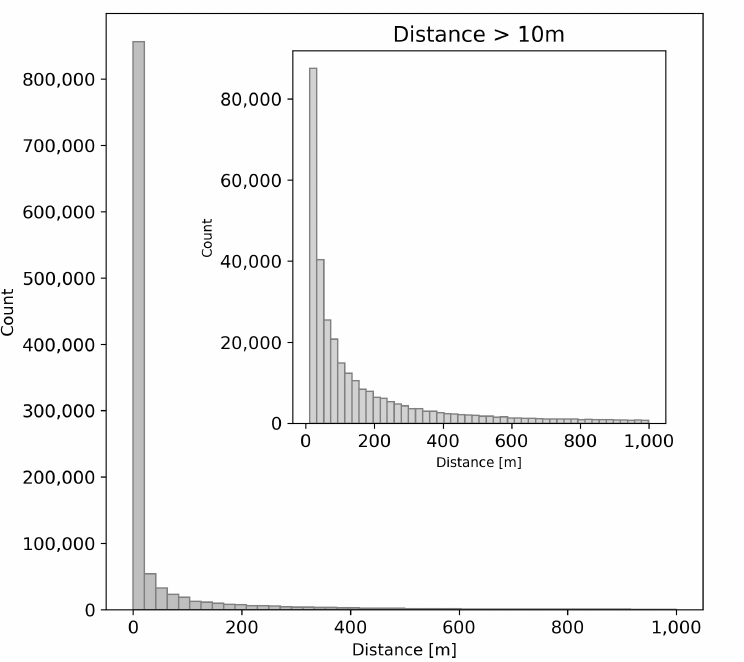
Figure 1. Distance between GPS measured and theoretical points (OBS_DIST attribute). A total of 35,509 points with a distance of more than 1000 m are not shown in this